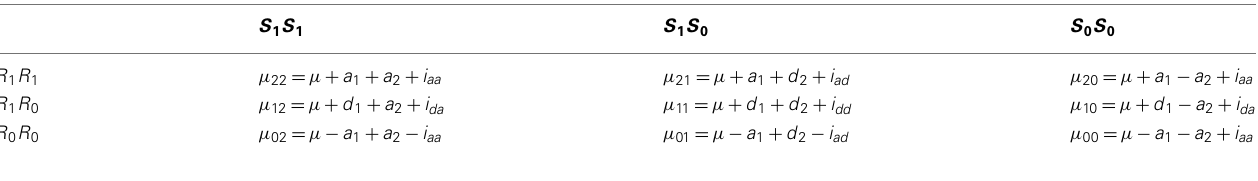
Table 4 |The genotypic values of across-block composite diplotypes in terms of additive and dominant effects at each block and interactions between two